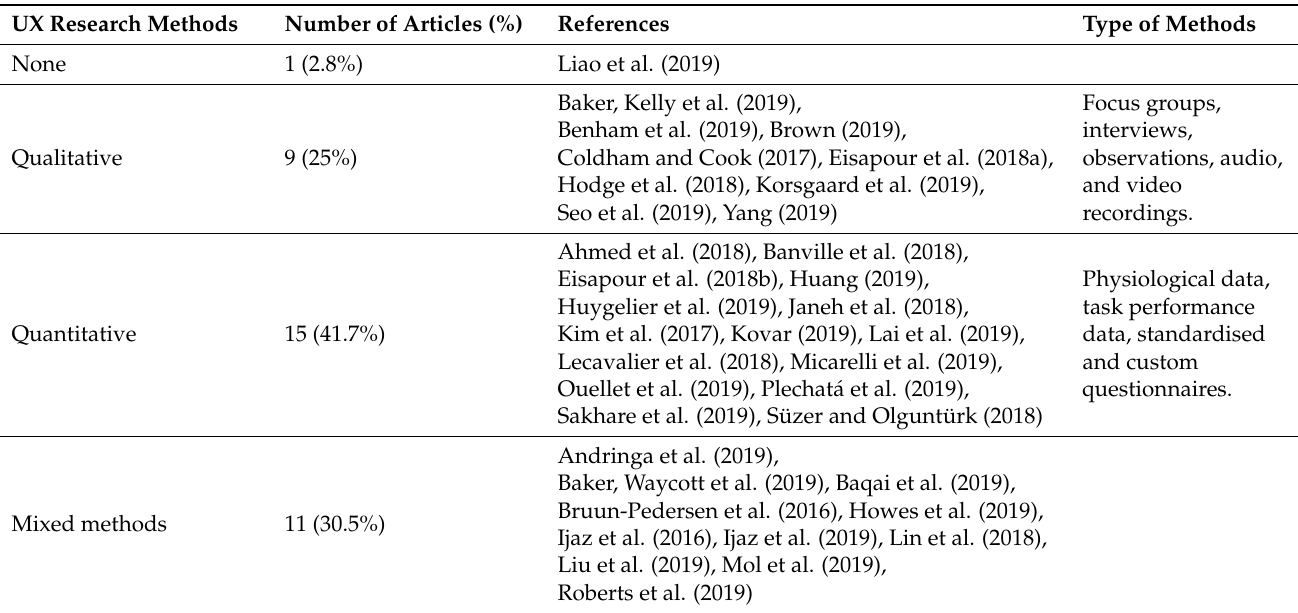
Table 2. Research methods